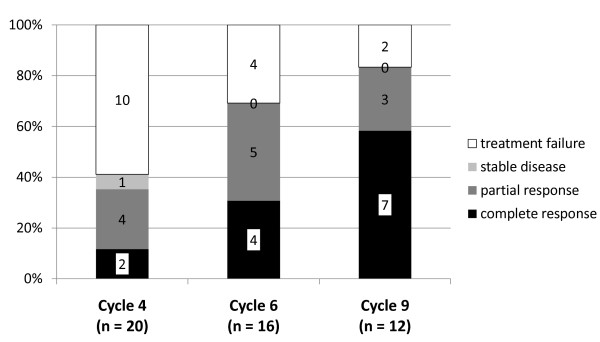
Response rate during DSG treatment. Response rate (CR in black, PR in dark grey, SD in bright grey, TF in white) at cycles (CYC) 4, 6 and 9 (ITT population). *In both cycles 4 and 6, three patients were not assessable.